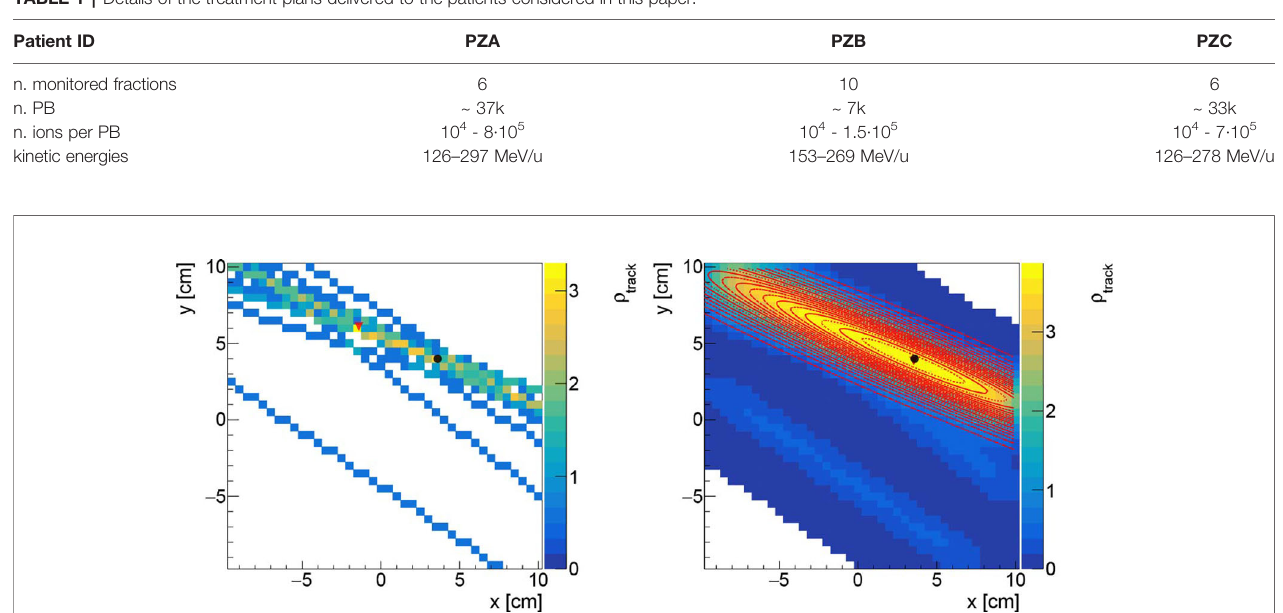
FIGURE 3 | Left: Track density histogram for a PB with 17 reconstructed tracks (no fi lter applied). Right: the same fi gure is drawn applying a Gaussian fi lter with s f equal to 1.0 cm. Both fi gures are obtained with a binning of 3 mm in both axis. The black (circle) and the red (triangle) markers represents respectively the nominal beam position, and the reconstructed one. The 2D Gaussian fi t is super-imposed (red curves).